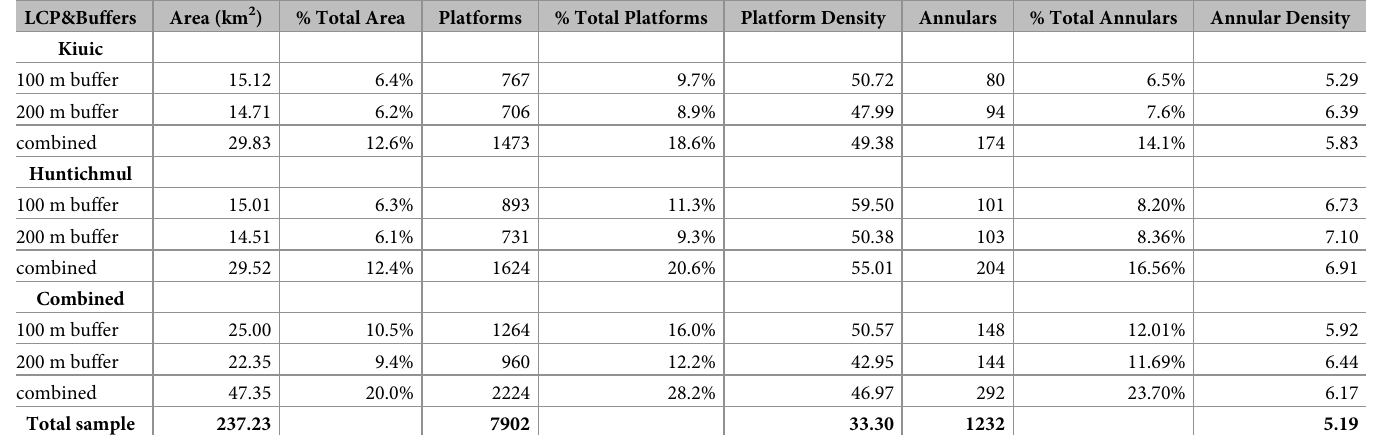
Table 10. Settlement along least-cost